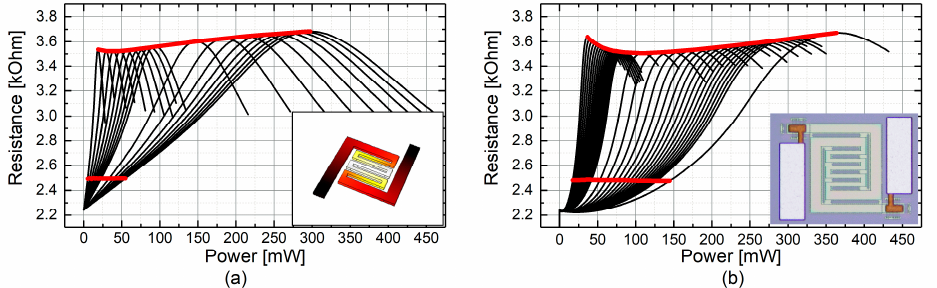
Figure 3. ( a ) Modelled and ( b ) measured gauge heating response at different pressured.